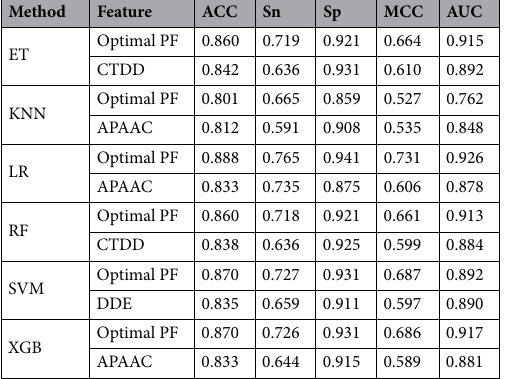
Table 4. Performance comparison of new feature representation with conventional sequence-based feature descriptors as evaluated on the cross-validation